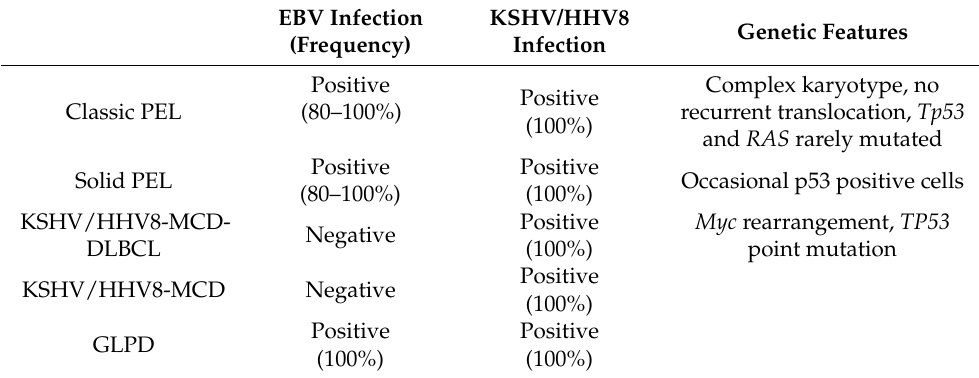
Table 2. Virologic association, and genetic features in KSHV/HHV8-MCD, PEL, KSHV/HHV8-DLBCL, and GLPD.